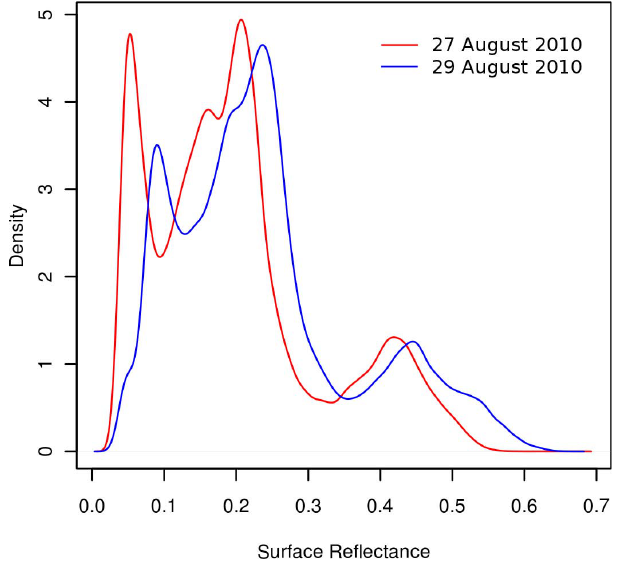
Fig. 4. Density plot of MODIS Band 6 reflectance values over the flooded region on 27 and 29 August 2010. The peaks at reflectance values of 0.05 and 0.1 represent water, as is seen later in the kappa